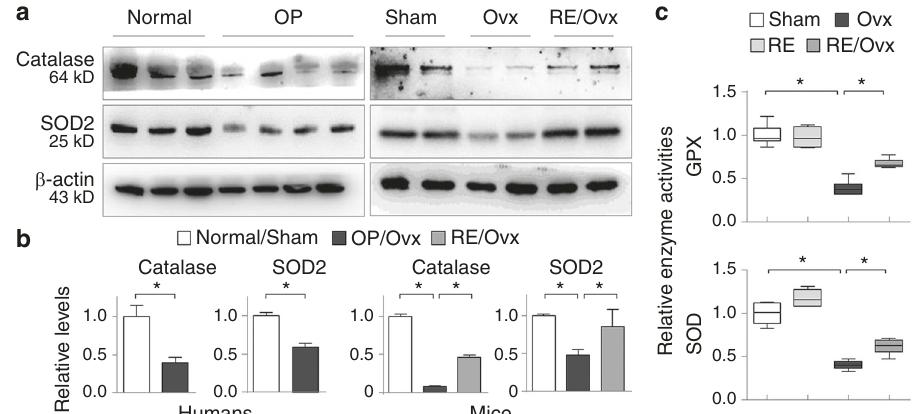
Fig. 5 Running exercise mitigates the suppression of antioxidant enzymes. a Western blotting of femoral catalase and SOD2 from 3 healthy controls and 4 patients with OP, as well as the sham, ovariectomized and RE/ovariectomized mice (6 mice in each group, two randomly selected samples from each group are shown). b Quanti fi cations of samples in Fig. 5a. * P < 0.05, one-way ANOVA. c The enzyme activities of GPX and SOD were examined from mouse femoral homogenates of the sham, RE, Ovx and RE/Ovx groups. Data are presented as the mean ± SEM of all experimental mice. * P < 0.05, two-way (Fig. 7). These results uncover an important epigenetic feature of the pathogenesis of OP that links the epigenetic modulatory